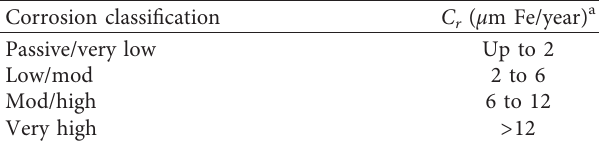
Table 3: Typical corrosion rates from LPR measurements. Corrosion